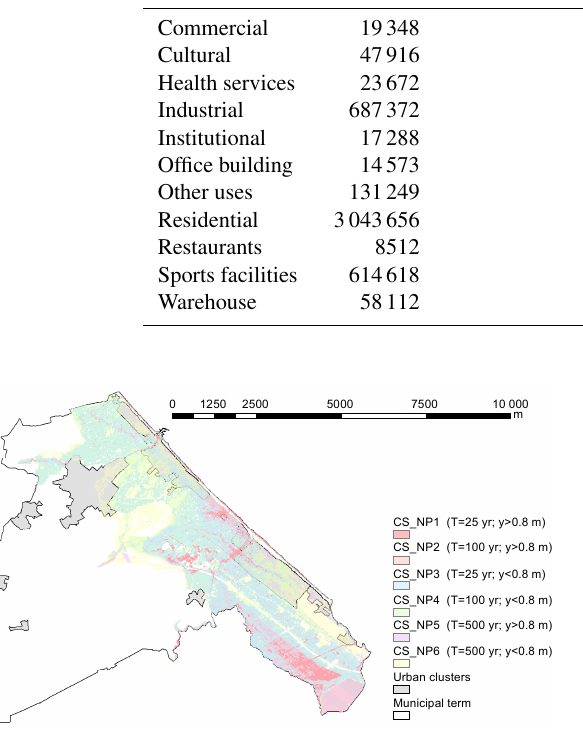
Figure 6. Hazard level map for scenario 0 (current